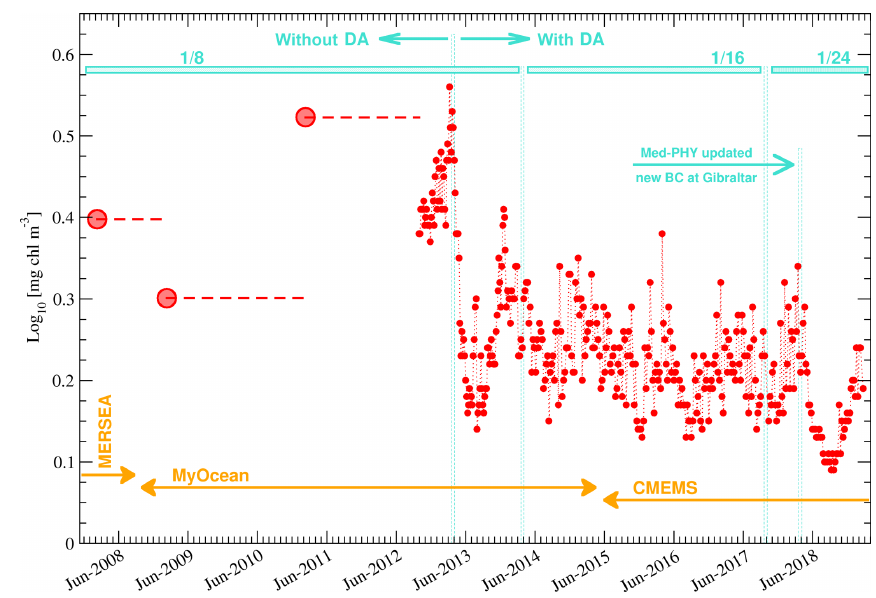
Figure 14. RMSD of the surface chlorophyll concentration with satellite data. The use of logarithmic units has been the standard for RMSD since the implementation phase. Regular, weekly product quality assessment (red dots and dotted line) started at the end of 2012. Before, quality assessment was performed only occasionally for specific periods (e.g. Teruzzi et al., 2011; Tonani et al., 2012; large red dots and thick red lines). In the plot, we identify the different projects (yellow), the start of data assimilation (April 2013), and the increase in horizontal resolution